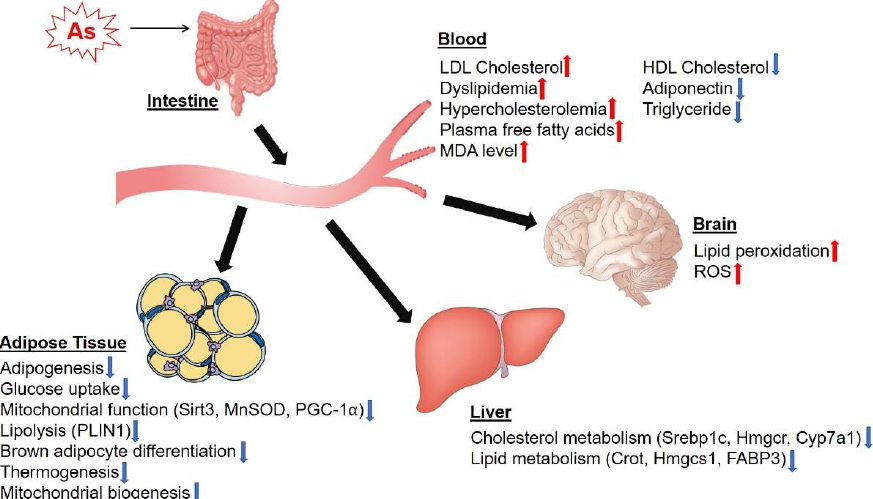
Figure 2. The effects of As on cholesterol and lipid metabolism in various tissues. When high-dose As uptake occurs in the intestines, As is delivered to metabolic tissues such as liver and adipose tissues. The accumulation of As in adipose tissues resulted in the inhibition of adipogenesis, mitochondrial function and thermogenic function. The dysregulation of lipid metabolism caused by As in adipose tissue affects lipid and cholesterol levels in the blood, and eventually alters lipid and glucose metabolism in other metabolic tissues such as the liver and muscles. Note: LDL, low-density lipoprotein; HDL, high-density lipoprotein; MDA, malondialdehyde; ROS, reactive oxygen species; Sirt3, sirtuin 3; MnSOD, manganese superoxide dismutase; PGC-1 ⍺ , peroxisome-proliferator- activated receptor-gamma coactivator 1 ⍺ ; PLIN1, perilipin; Srebp1c, sterol regulatory element-